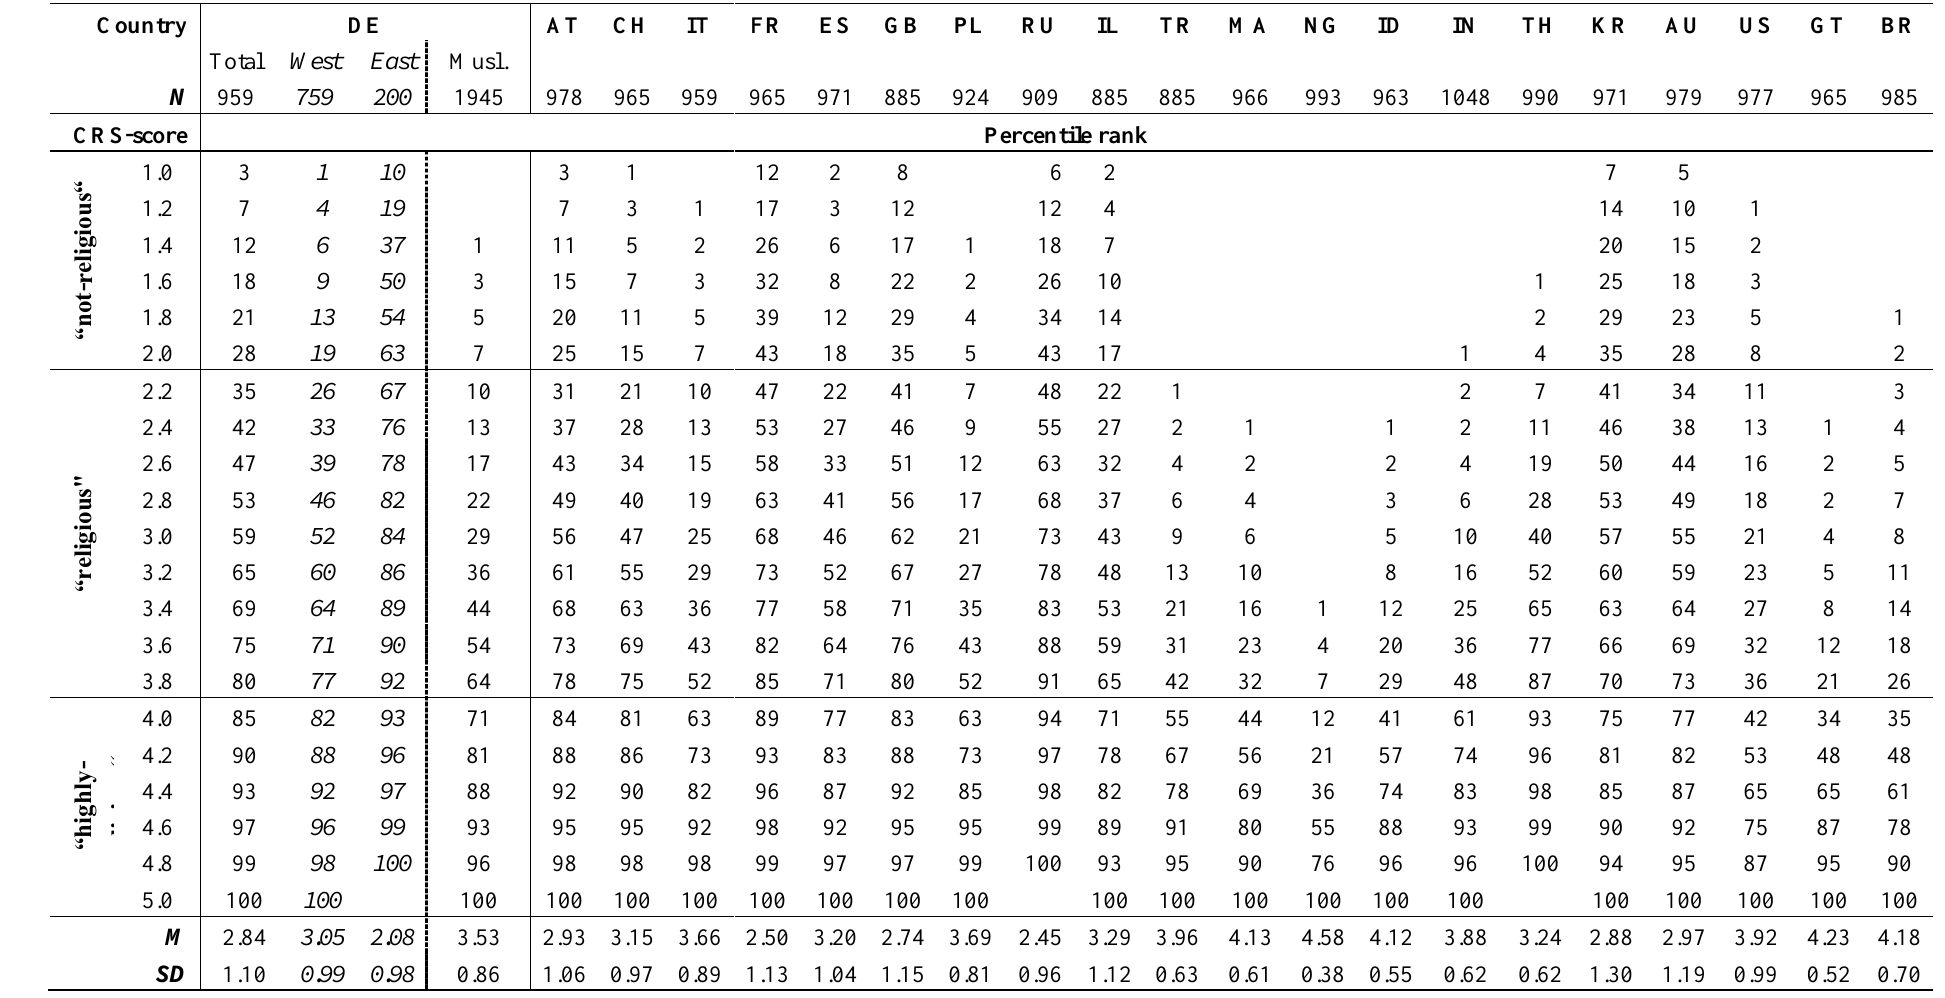
Table 5. Norm values of CRSi-7 (21